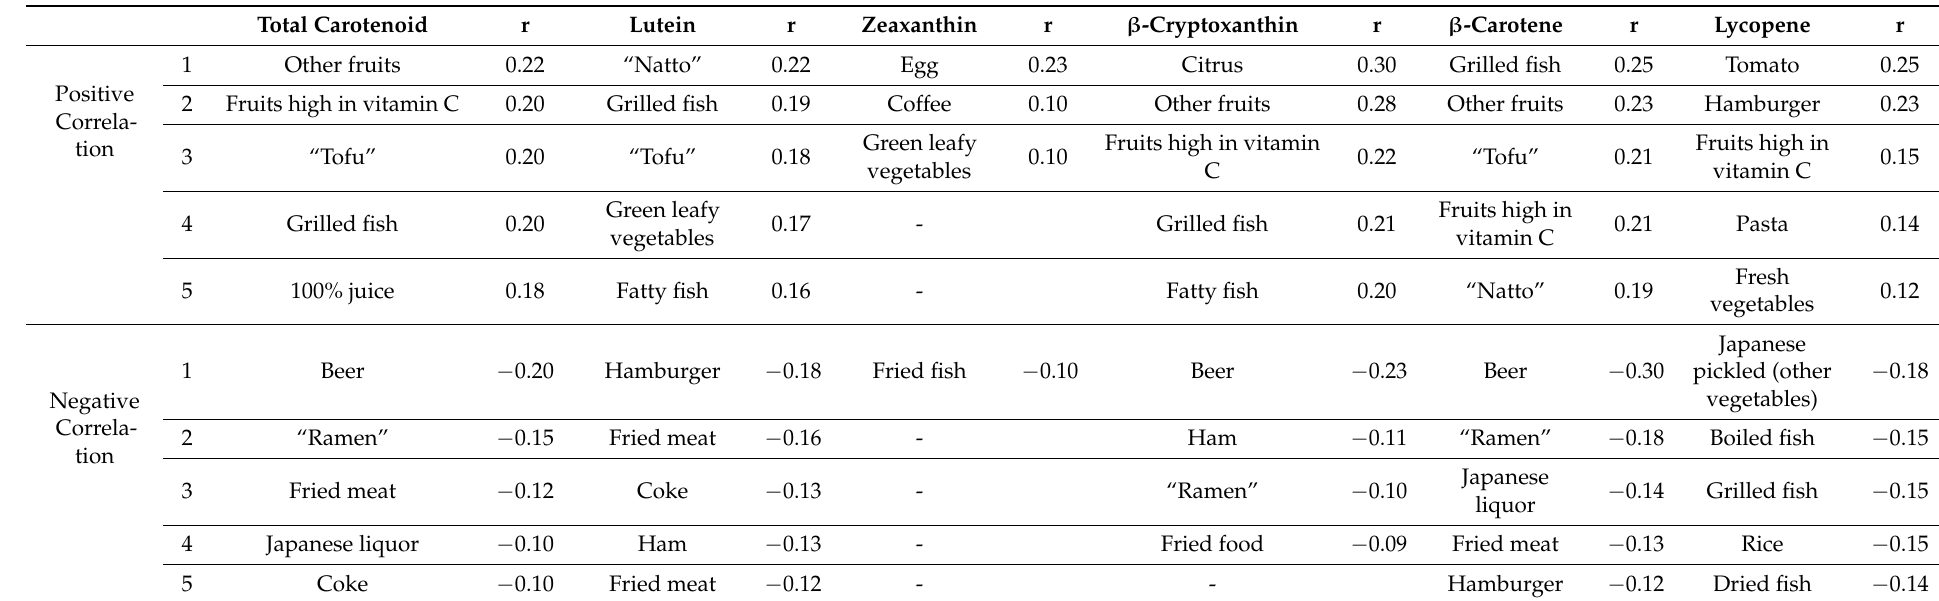
Table 6. Top five food groups that significantly correlated with serum carotenoids in